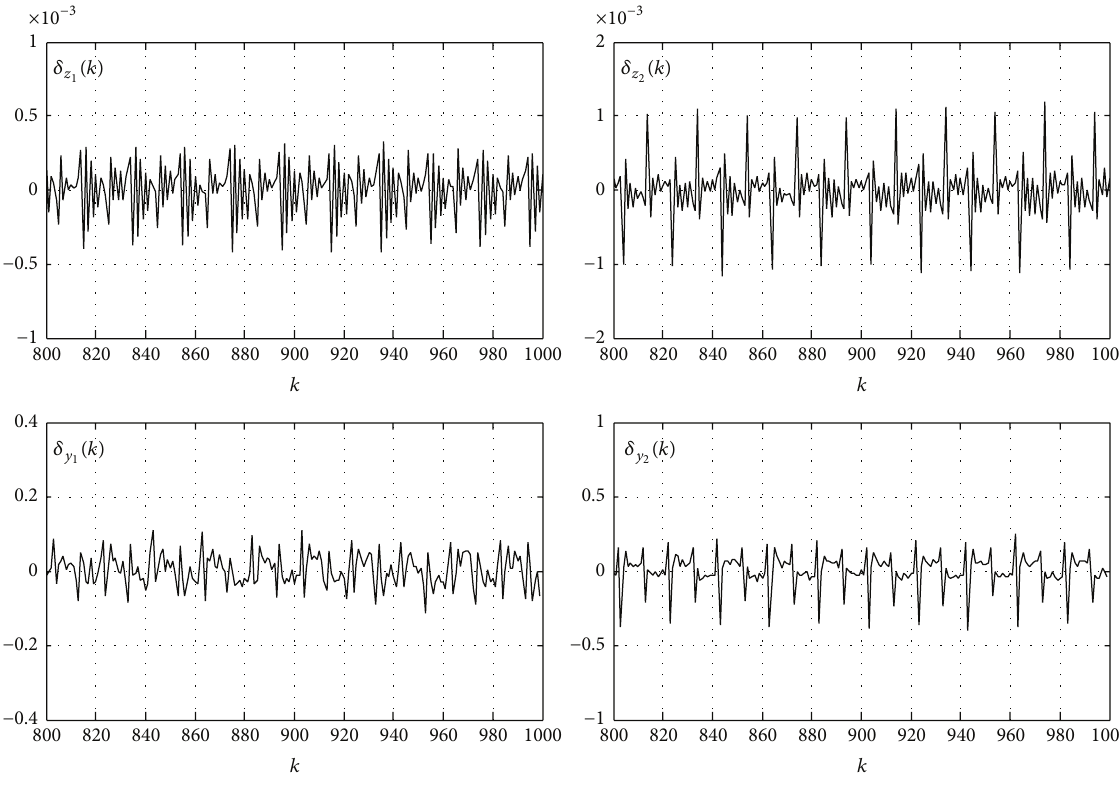
(𝑘) , 𝛿 (𝑘) , 𝛿 (𝑘) , and 𝛿 𝑧 2 𝑦 1 1